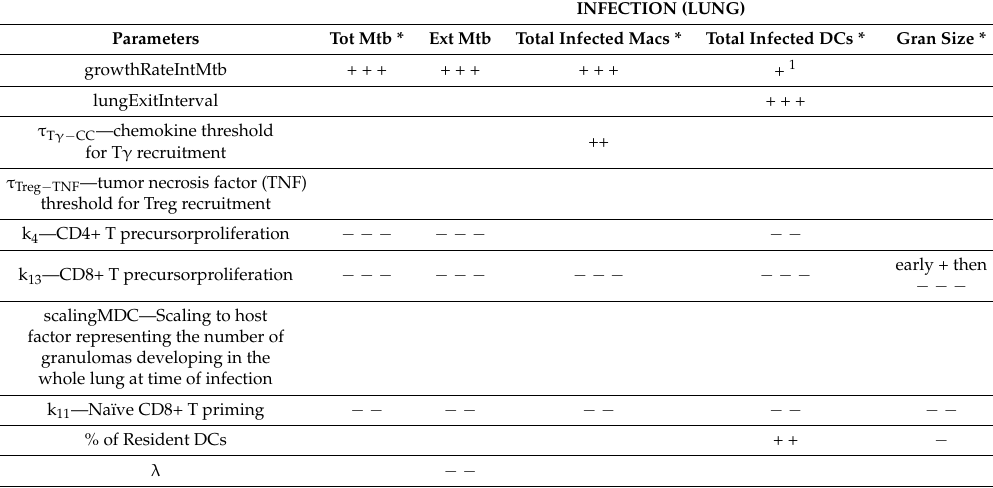
Table 2. Significant Partial Rank Correlation Coefficients (PRCCs) for inflammation outcomes. List of all the parameters/mechanisms (rows) that have a significant (i.e., p < 10 − 3 ) PRCC with respect to outputs of the model that are directly related to some markers of infection (columns). See Appendix B for a detailed description of the outcomes analyzed here. A + (or − ) indicates a positive (or negative) correlation between the parameter and the infection level outcome. The magnitude/strength of the correlation is given by the number of + (or − ). The table recapitulates, whenever possible, the dynamics over time. The outputs with * are selected as examples to illustrate PRCC time courses (see Figure 5). Ext Mtb means extracellular bacteria that is not inside DCs or macrophages, Tot Mtb means total bacteria intracellular and extracellular, Gran size means actual measure of the granuloma diameter. The parameters τ define thresholds for T cell recruitment at each vascular source (in terms of number of molecules). The parameter λ represents the frequency of Mtb-specific Naïve T cells in the blood/LN (see Appendix A for details on all the parameters listed